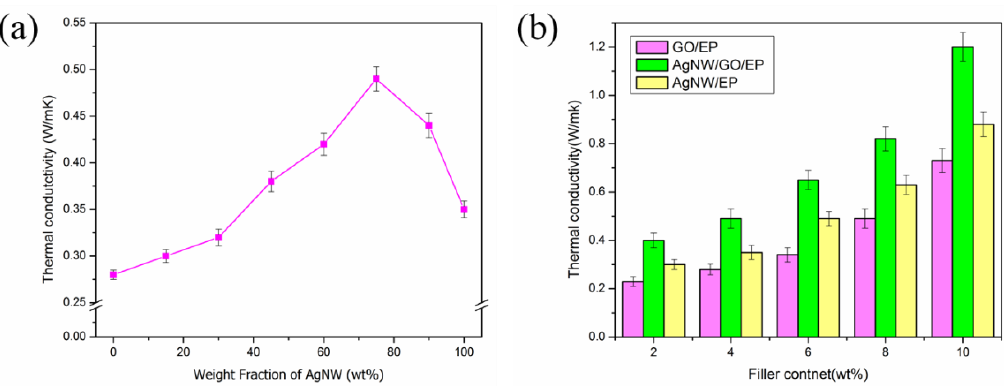
Figure 6. ( a ) Thermal conductivities of AgNW/GO composites as a function of AgNW loading. ( b ) Thermal conductivities of AgNW/GO composites filled with different amounts of hybrid filler with 75% AgNWs.